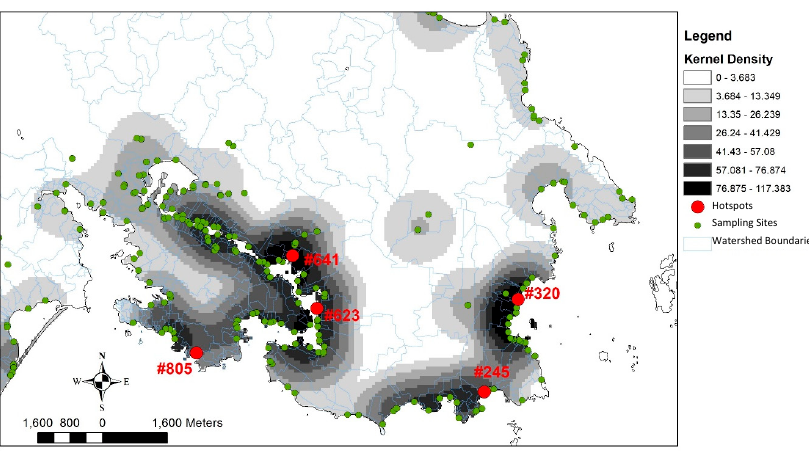
Figure 4. Density map based on the Log FC value of samples. Density values shown in the legend are in units of km 2 .